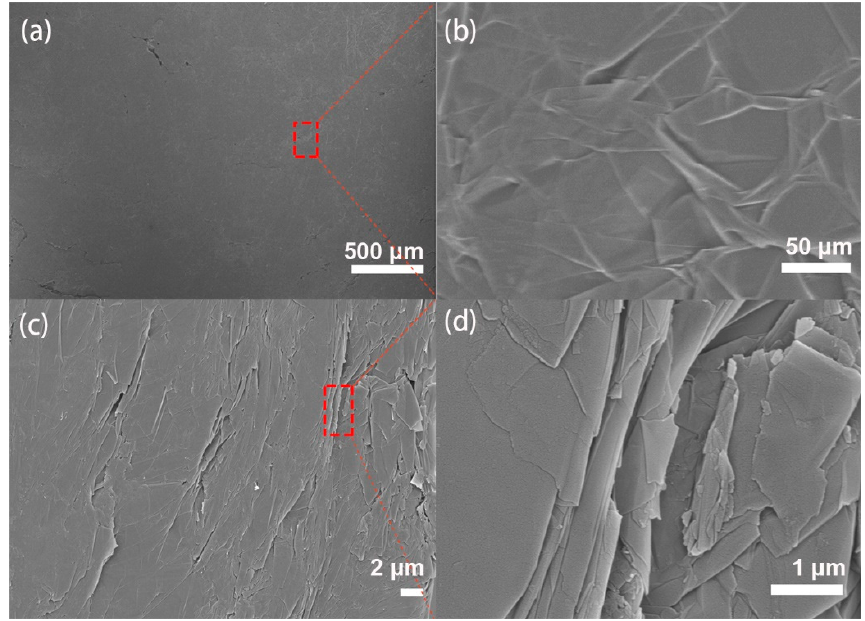
Figure 2. SEM images of GNP sheets. The morphology of the frontal ( a,b ) and side cross-section ( c,d ).